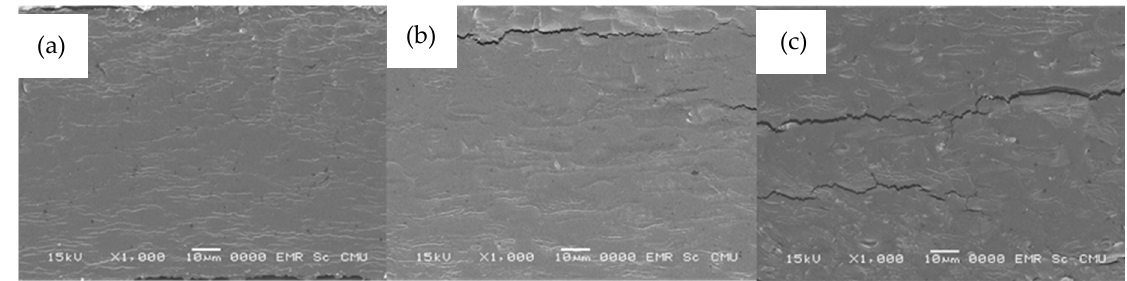
Figure 5. SEM micrographs (×1000) of cassava starch/gelatin composite films ( a ) without antioxidant, ( b ) with quercetin, and ( c ) with TBHQ.